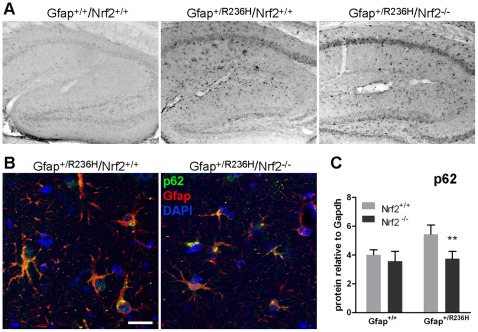
p62 in Gfap+/R236H mice colocalizes with Gfap aggregates and is reduced with loss of Nrf2.(A) p62 immunohistochemistry in hippocampus from Gfap+/R236H/Nrf2+/+ mice shows astrocytic cells that are not apparent in Gfap+/+ mice. Gfap+/R236H/Nrf2−/− mice show similarly stained cells (3 mos of age). (B) Confocal microscopy with immunofluorescence for p62 (green) shows colocalization with Gfap aggregates (red) in both Nrf2+/+ and Nrf2−/− Gfap+/R236H mice (8 wks of age). (C) Western blot analysis of hippocampal protein shows increased p62 in Gfap mutant mice compared to wild-type, with Gfap+/R236H/Nrf2−/− mice having levels reduced to that of wild-type mice (8 wks of age, n≥4, t-test **p>0.01, comparing Gfap+/R236H/Nrf2+/+ with Gfap+/R236H/Nrf2−/−). Scale bar = 25 µm (shown in B, applies to both confocal images).